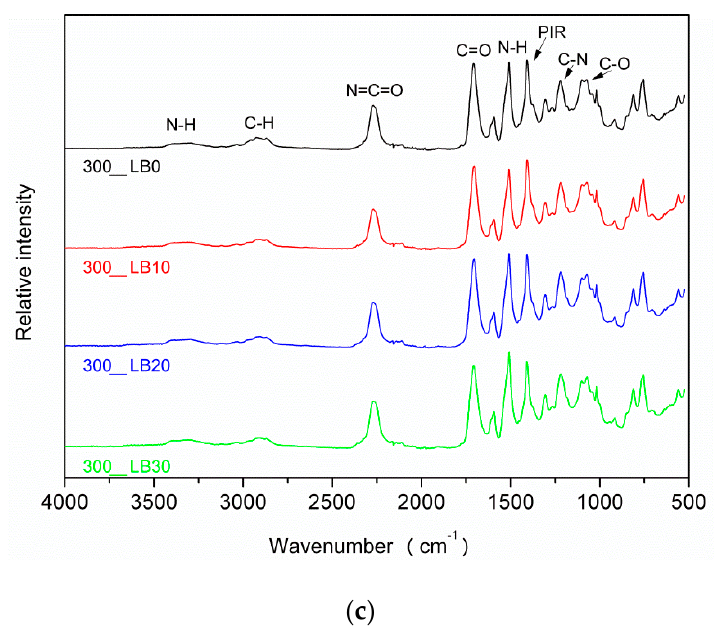
Figure 5. FTIR spectra of PUR-PIR foams: ( a ) I ISO = 200, ( b ) I ISO = 250, ( c ) I ISO = 300.